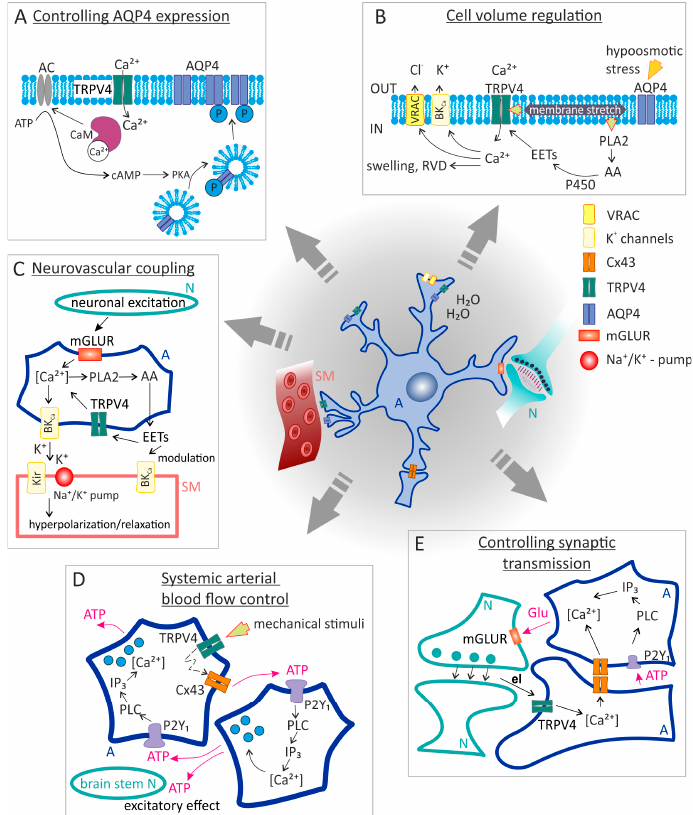
Figure 2. Basic functions of astrocytic TRPV4 channels. ( A ) Influence of AQP4 expression in astrocyte membrane: Ca 2+ entering the cell through TRPV4 channels binds to CaM, which subsequently acti- vates AQP4 phosphorylation, causing its re-localization to the astrocytic membranes. ( B ) Cell-volume regulation: The mechanism involves cooperation between the AQP4 and TRPV4 channels. The water influx via AQP4 causes astrocyte swelling, which activates the mechanosensitive TRPV4 channel. Subsequent entry of Ca 2+ triggers RVD via BK Ca or VRACs. Additionally, the membrane stretch can activate PLA2, whose activity leads to the production of AA and its subsequent conversion to EETs. EETs can then further stimulate TRPV4 channels. ( C ) Neurovascular unit: Astrocytic mGluRs sense the extracellular glutamate released from neurons due to their increased activity. The activation of mGluRs leads to the Ca 2+ influx and following stimulation of BK Ca releasing K + into the ECS. Extracellular K + activates Kir channels in SM cells, causing vasodilation. In addition, PLA2 activation leads to the production of EETs, the opening of TRPV4 channels, and an additional Ca 2+ increase in astrocytes. ( D ) Systemic blood flow control: Mechanical stimulation of TRPV4 opens the channel for Ca 2+ entry into astrocytes and activates the interaction between TRPV4 and Cx43 hemichannels. Sub- sequent release of ATP into the ECS can trigger activation of astrocytic P2Y1 or neuronal purinergic receptors of brain stem sympathetic control circuits. Moreover, astrocytic P2Y1 activation enhances as- trocytic excitation by stimulating the further Ca 2+ release from internal stores. ( E ) Control of synaptic transmission: Activation of astrocytic TRPV4 channels by the endogenous ligand leads to excitation of neighboring astrocytes, even those that do not express TRPV4, either via gap junction mediated Ca 2+ waves or by ATP release. These astrocytes then release glutamate, which binds to mGluRs on synaptic neurons and thus modulates the neurotransmission. Abbreviations: A, astrocyte; AA, arachidonic acid; AC, adenylyl cyclase; AQP4, aquaporin 4; ATP, adenosine triphosphate; BK Ca , Ca 2+ -dependent K + channels; CaM, calmodulin; ECS, extracellular space; EETs, eicosanoid metabolites; el, endoge- nous ligand; Kir, inward-rectifier potassium channel; mGluRs, metabotropic glutamate receptors; N , neuron; P2Y1, G-protein coupled purinergic receptor P2Y1; PKA, protein kinase A; PLA2, phos- pholipase 2; RVD, regulatory volume decrease; SM, smooth-muscle cell; VRAC, volume-regulated anion channel. The figure was inspired by schematics in publications by Kitchen et al., 2020 [120], Jo et al., 2015 [113], Turovsky et al., 2020 [133] and Shibasaki et al., 2014